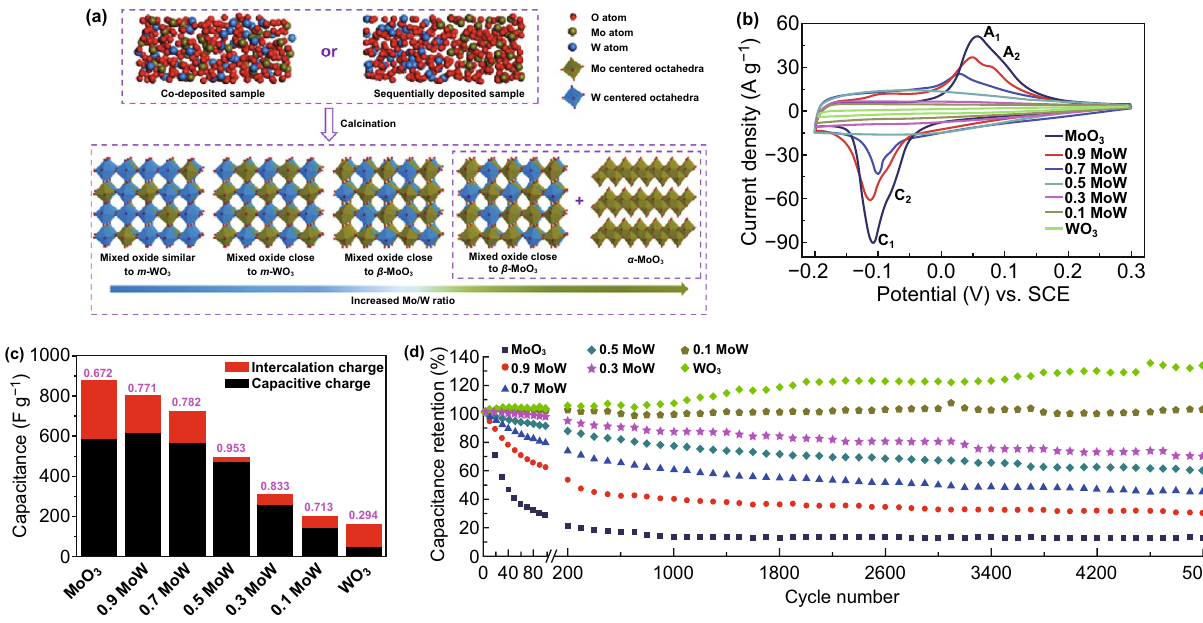
Fig. 29 a Schemes of the formation mechanism and crystal structure of Mo–W mixed oxides. b CV curves, c capacitance contributions (capaci‑ tive vs. diffusion‑controlled processes), d cycling stability, and e ion transport patterns of different Mo–W mixed oxides. Reproduced from Ref. [276] with